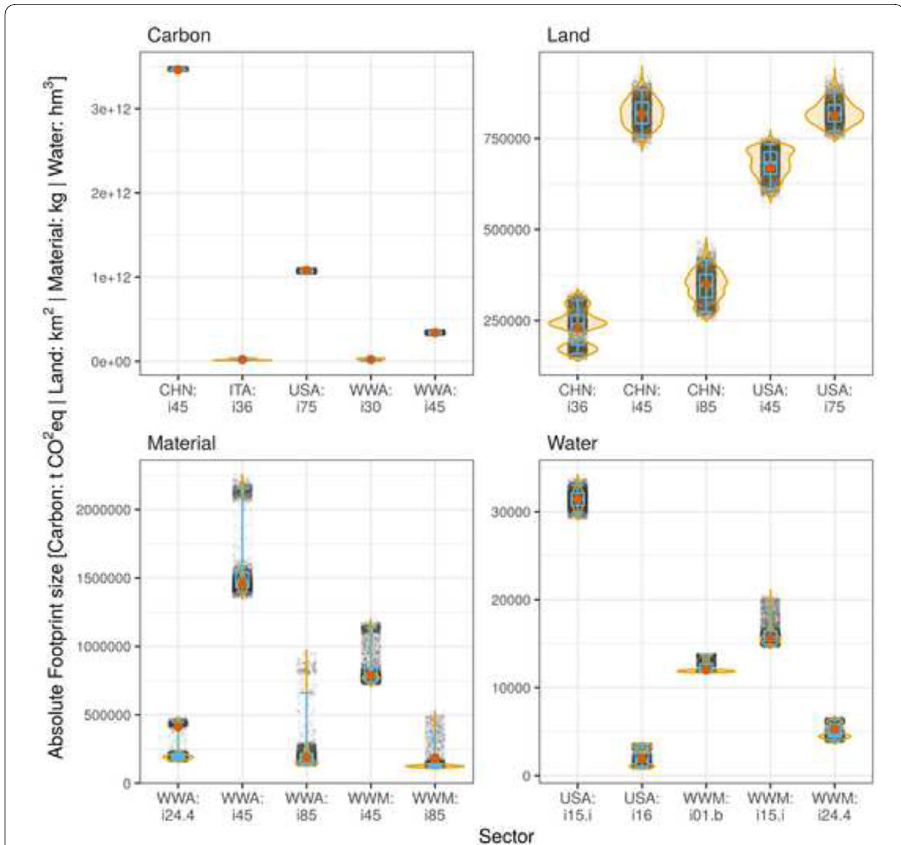
Fig. 7 The sample distributions of the top five industries with the highest SD for each footprint category. The industries are ordered by their SD from left (high) to right (low). The red points show the footprints size assuming proportional import